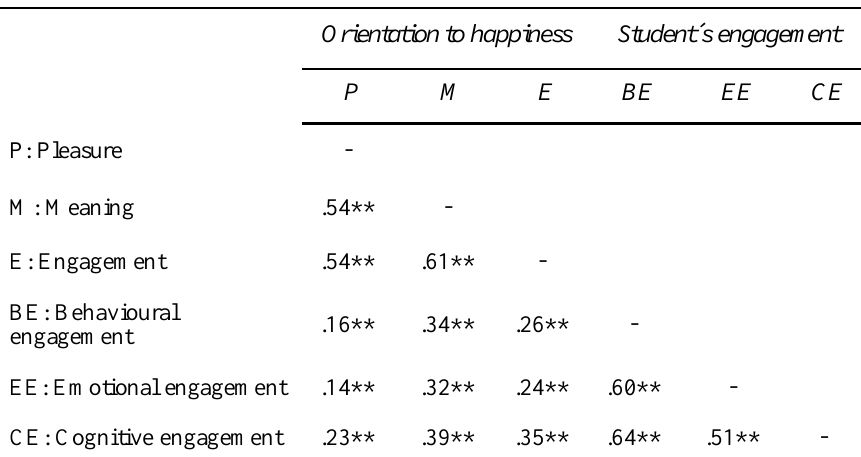
Correlation matrix Orientation to happiness Student´s